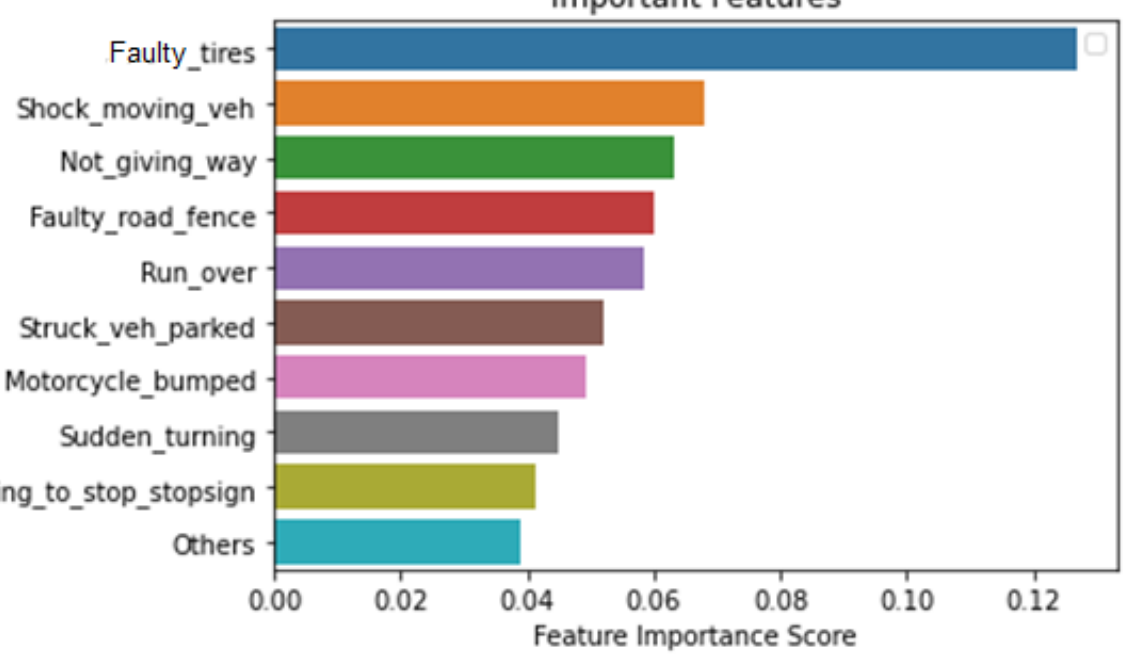
Figure 6. Variable importance using random forest classifier.